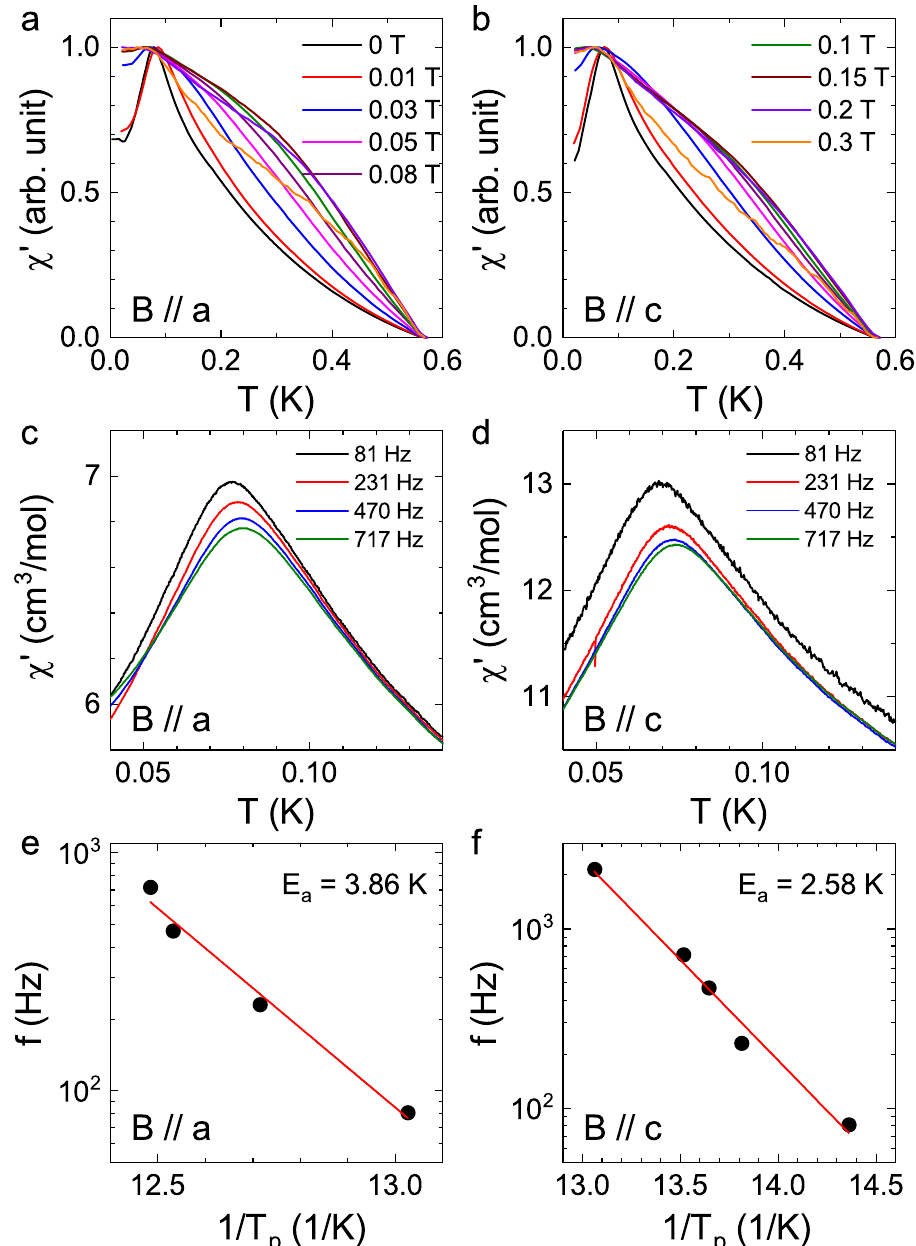
Fig. 6 AC susceptibility of YbMgGaO4. a , b Temperature dependence of the real part of the AC susceptibility, χ ′ , measured with different DC magnetic fi elds along either the a -axis or the c- axis. Here, the maximum value of each data was scaled to 1 to clearly show the DC magnetic fi eld effects on AC susceptibility. c , d The Frequency dependence of the χ ′ peak. Here, the absolute value of the AC susceptibility was obtained by rescaling it to the DC susceptibility (see Supplementary Information). e , f Arrhenius law fi t of the χ ′ peak position, T 0 . The applied AC excitation fi eld (~1 Oe) is along either the a- axis for ( c , e ) or the c -axis for ( d , f